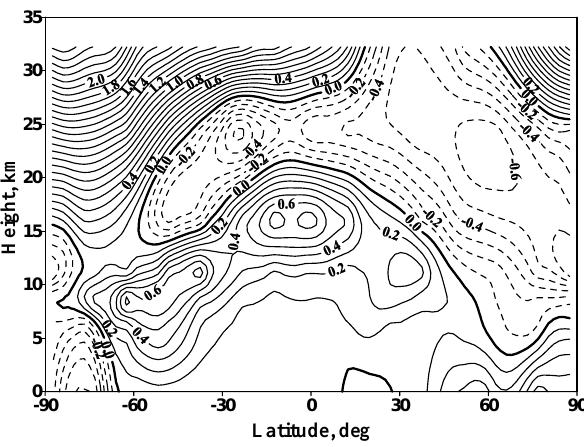
Fig. 4. The estimated linear rate of the zonally averaged tempera- ture changes during 1959–2002, K/decade.